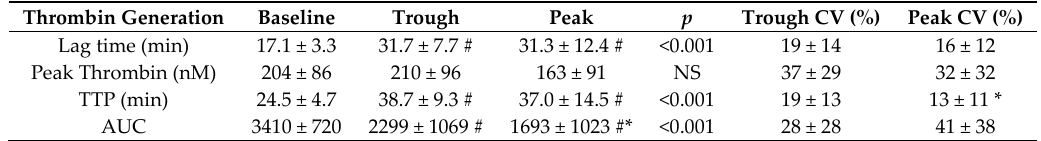
Table 1. Thrombin generation in “ex vivo” samples before therapy initiation (baseline), at trough and at peak dabigatran levels. Means ± standard deviations are shown with ANOVA p values for comparison between baseline, trough and